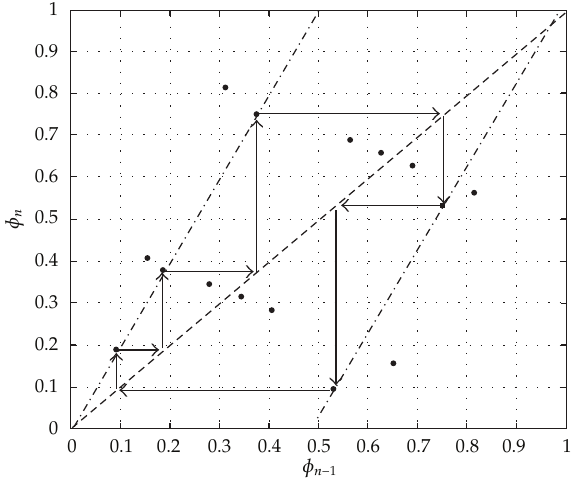
Figure 6: The evolution of characteristic function of the period-5 attractor, where the values of characteristic function of the attractor are 0.0938, 0.1875, 0.3750, 0.7500, and 0.5313,